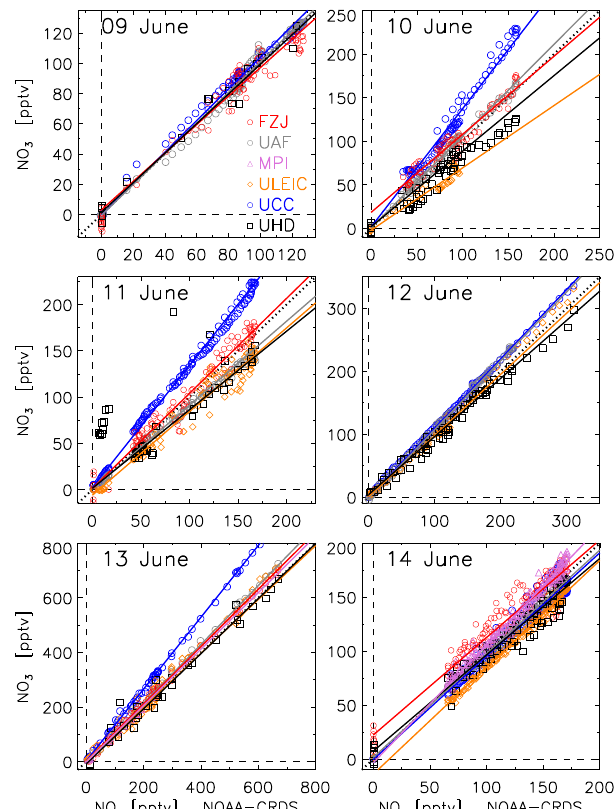
Fig. 7. Correlation and linear regression analysis for individual days of the intercomparison. The data sets were averaged to a com- mon 3min time grid. Linear regression lines calculated with the “fitexy” algorithm are shown colour coded for the particular instru- ments. The dotted black line is the ideal 1 : 1 line. Error bars were omitted for